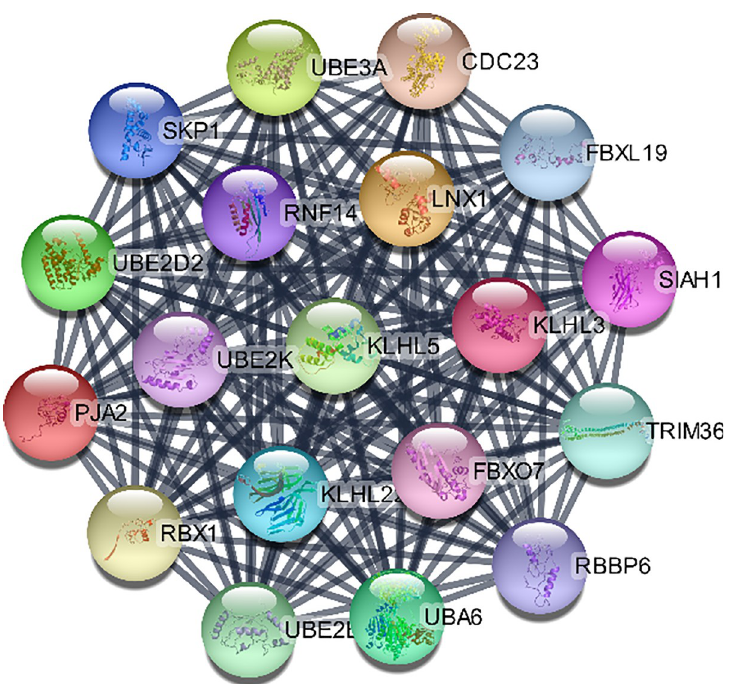
Fig 9. Cluster 1 based on MCODE